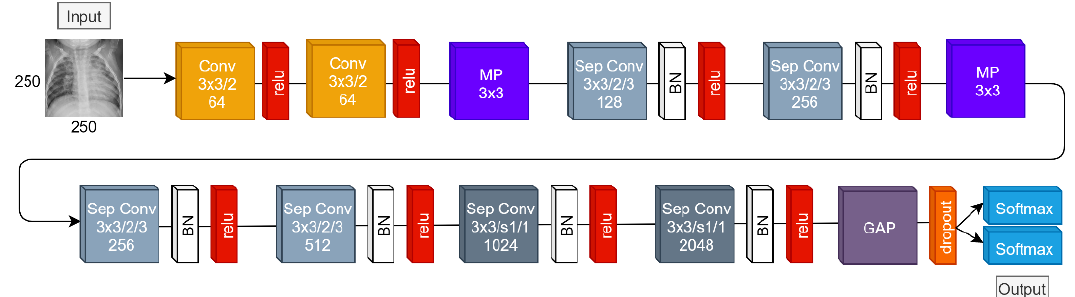
Figure 2. Block diagram of NanoChest-net. Table 1. Layer specification of NanoChest-net.